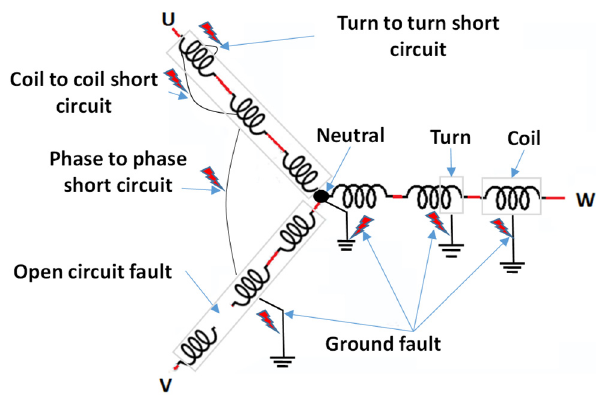
Figure 6. Schematic diagram for the emulated SC and OC faults on the stator windings.